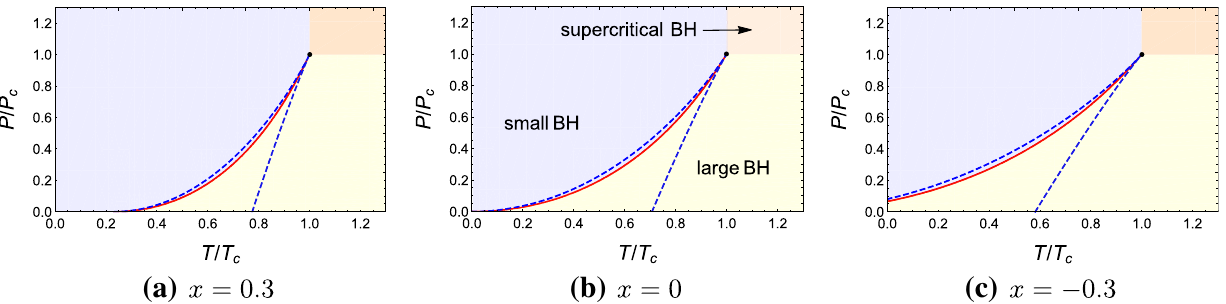
Fig. 3 Phase structure of dRGT black hole in reduced ( (cid:13) P , (cid:13) T ) space with x = 0 . 3, 0 and − 0 . 3. The solid red and blue dashed curves represent the small/large black hole coexistence curve and spinodal curves, respectively